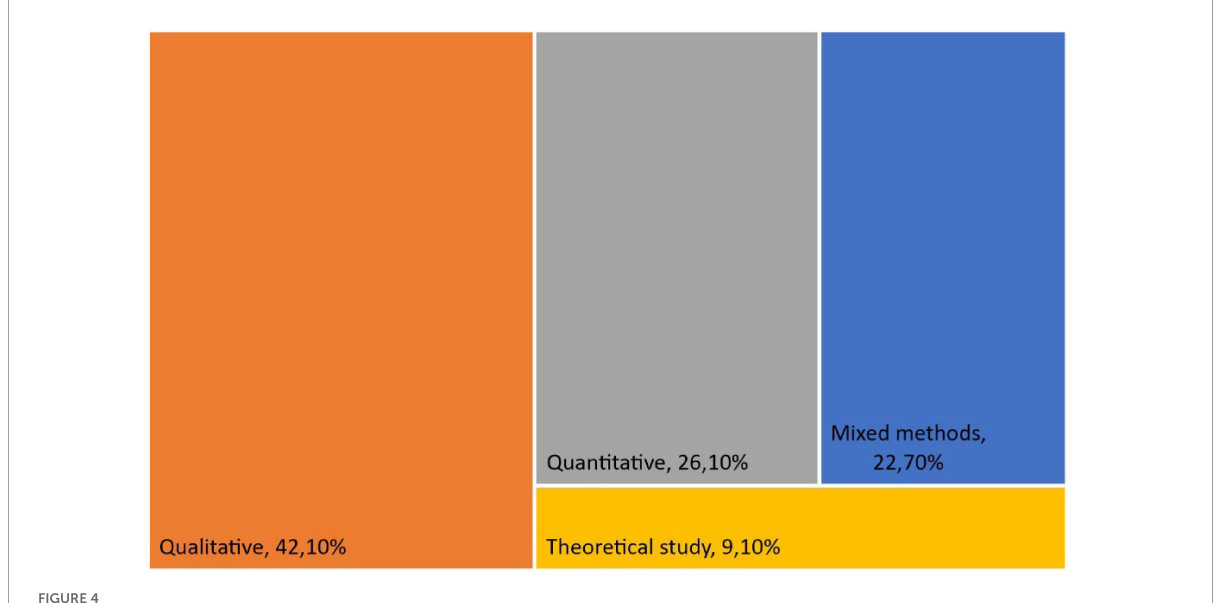
FIGURE4 Research methodologies of the selected